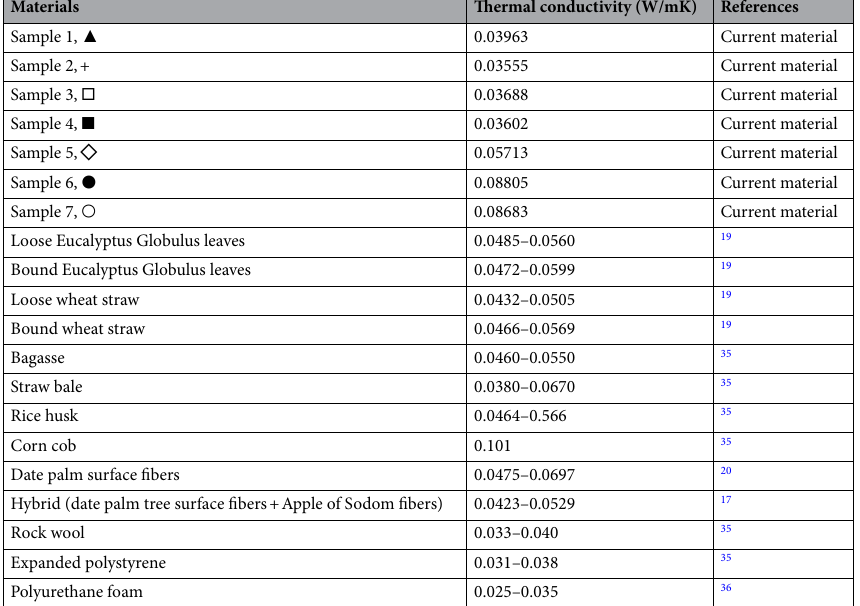
Table 4. Comparison between the thermal conductivity of the discarded facemask materials at different densities and other conventional and unconventional